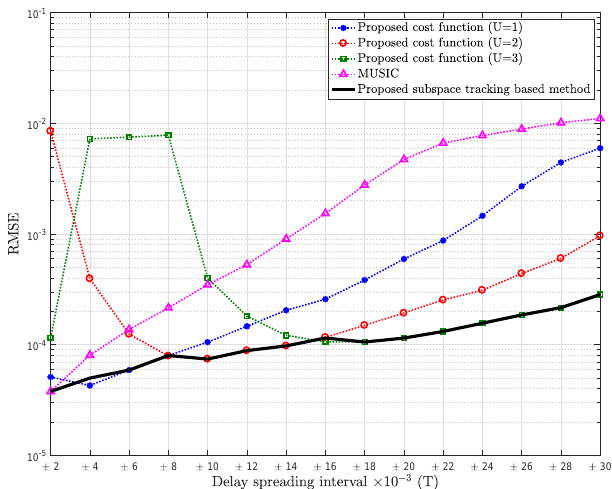
Figure 5. RMSE of mean delay estimation vs. delay spreading of the proposed cost function for U = 1, U = 2, and U = 3, the proposed subspace tracking-based method, and MUSIC; P l = 20, K = 64, SNR = 15 dB.